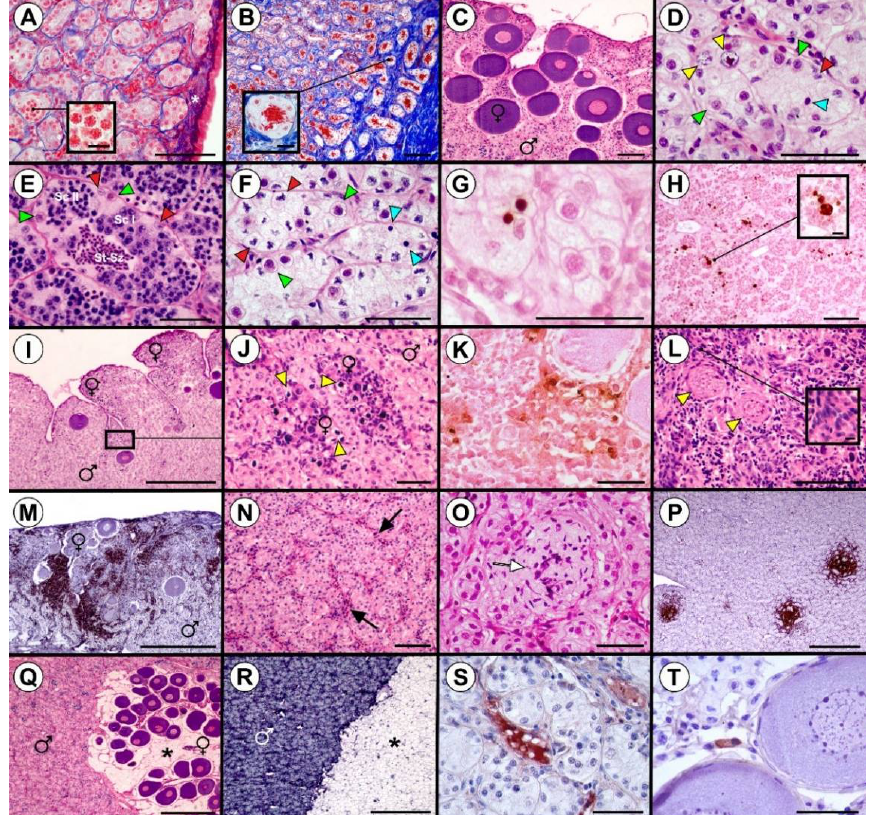
Figure 3. Testis ( A , B , P ) and intersex gonads ( C – O , Q – T ) of 1600th-day-post-hatching (dph)Russian sturgeon. ( A ) Low columnar epithelium on the testicular surface with a thin tunica albuginea and seminiferous tubules underneath. Magnification inside ( A ): Primary spermatocytes. ( B ) and magnification inside: Accumulation of spermatozoa (red) inside distal seminiferous tubules. ( C ) Intersex gonad with ovarian follicles located ventrally (female symbol ♀ ) and seminiferous tubules located dorsally (male symbol ♂ ). ( D ) Chromatin-nucleus oocytes inside seminiferous tubule. ( E ) Spermatogenesis in cysts of an enlarged seminiferous tubule. ( F ) Pre-meiotic seminiferous tubules with low spermatogonia density. ( G ) Apoptotic degeneration of spermatogonia in a pre-meiotic